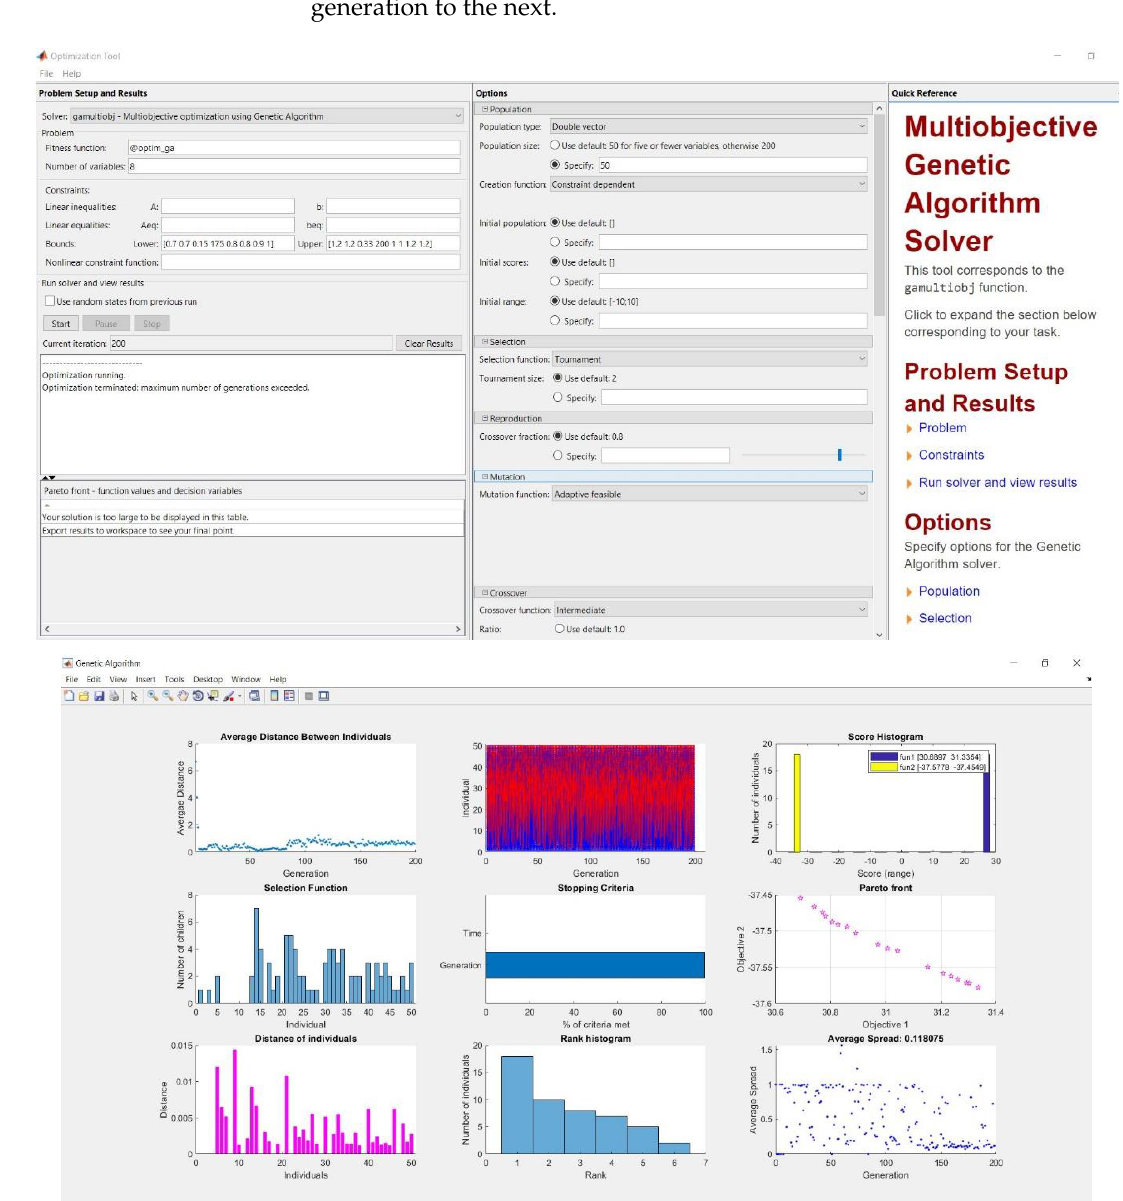
Figure 15. MATLAB simulation results. Similarly, Figure 16 depicts the Pareto frontier determined using the MATLAB opti- mization